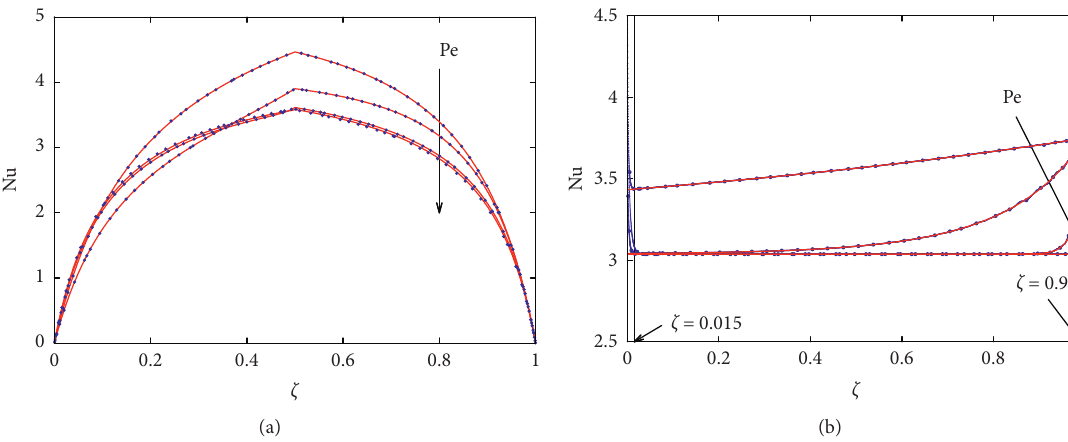
Figure 5: Comparison between numerical (blue curves with dots) and analytical results (red continuous lines) for Nu ( ζ ) versus ζ . The arrows indicate increasing values of Pe. Br � 0 . 1, Kn � 0 . 0, α � 0 . 02, β + � β − � 1, Pe � 10 − 2 , 10 − 1 , 10 0 , 10 1 . (a) Triangular wall heat flux. (b) Uniform wall heat flux.